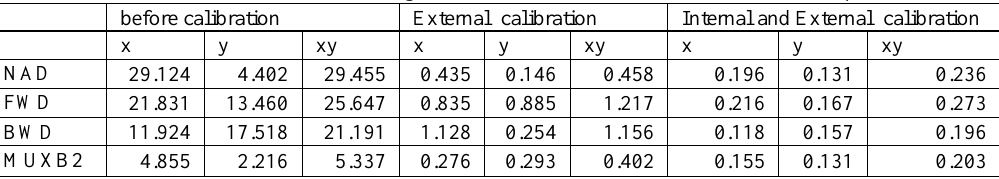
Table 3 the result of on-orbit geometric calibration for Satellite ZY3-02 (unit: pixel)